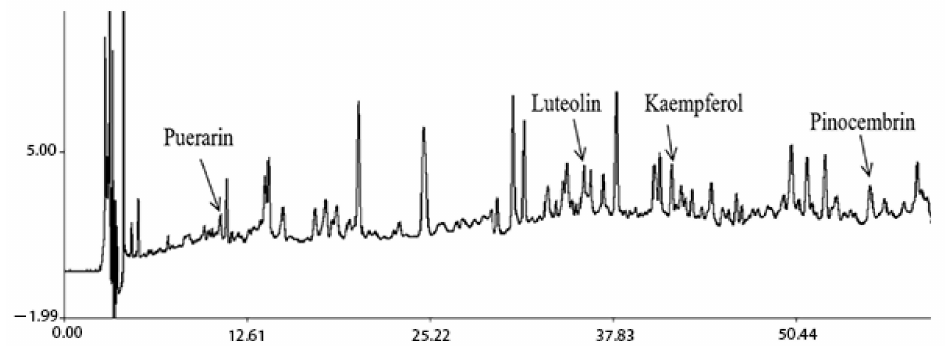
Figure 17. HPLC chromatogram of extracts from aerial parts of Glycyrrhiza uralensis